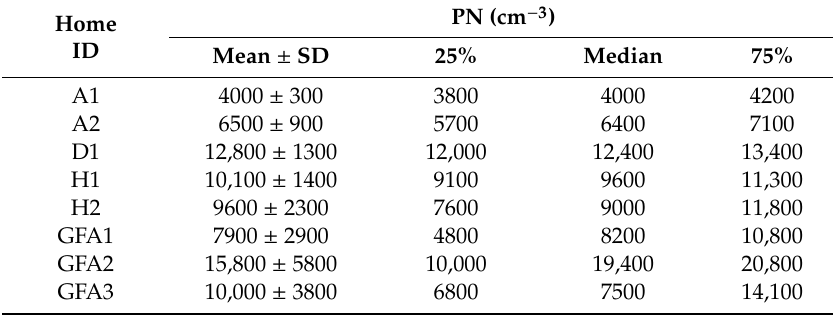
Table 1. Mean indoor particle number concentrations in Jordanian homes during background periods. Additional details on each home are found in the Supplementary Material: Figure S2 and Table S2.